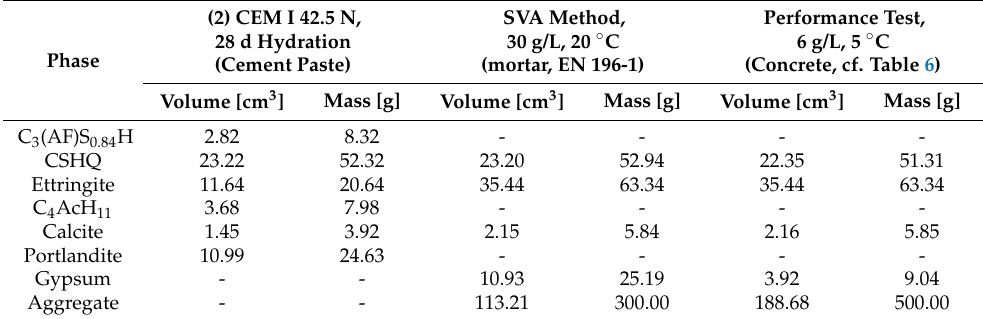
Table 7. Mass and volume balance of cement paste/mortar/concrete normalized to 100 g (2) CEM I 42.5 N plus aggregates after 28 d hydration, assuming equilibrium conditions in the SVA method at 30 g SO 42 − /L and 20 ◦ C, and in the new performance test at 6 g SO 42 − /L at 5 ◦